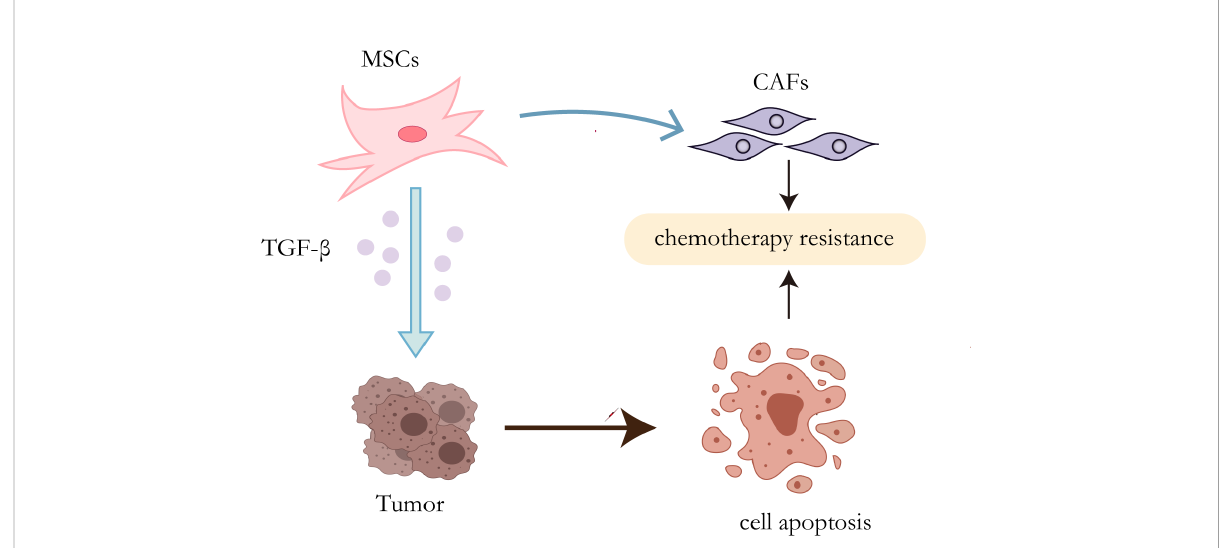
FIGURE 2 Resistance mechanisms of MSCs. On the one hand, TGF- b secreted by MSCs can induce autophagy of HCC cells, leading to chemotherapy resistance; on the other hand, MSCs can transform into CAFs to promote drug